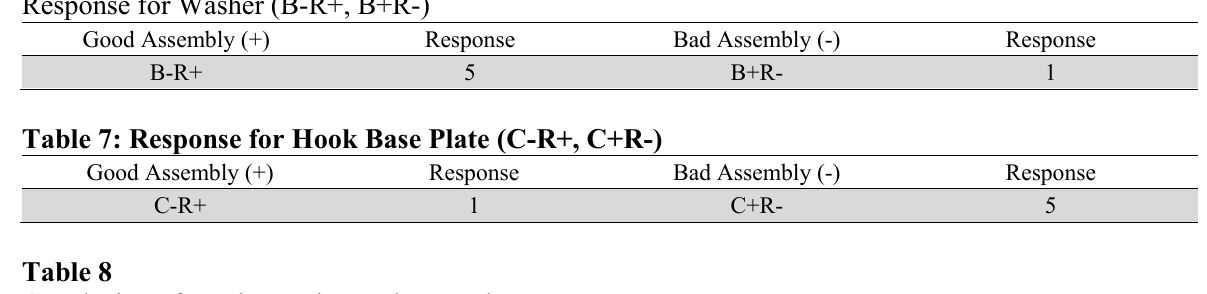
Conclusion of Hook, Washer and Base Plate